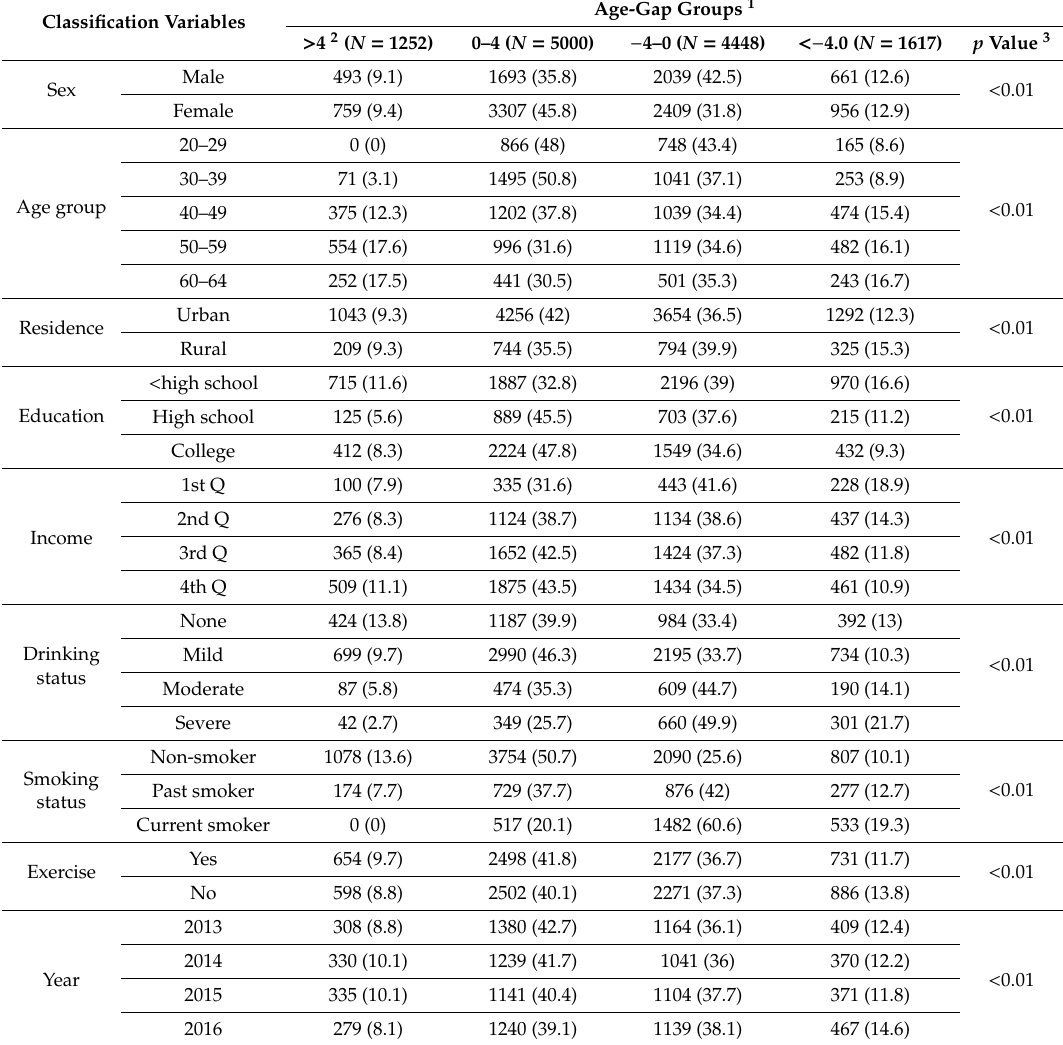
Table 1. Distribution of study population according to the age-gap